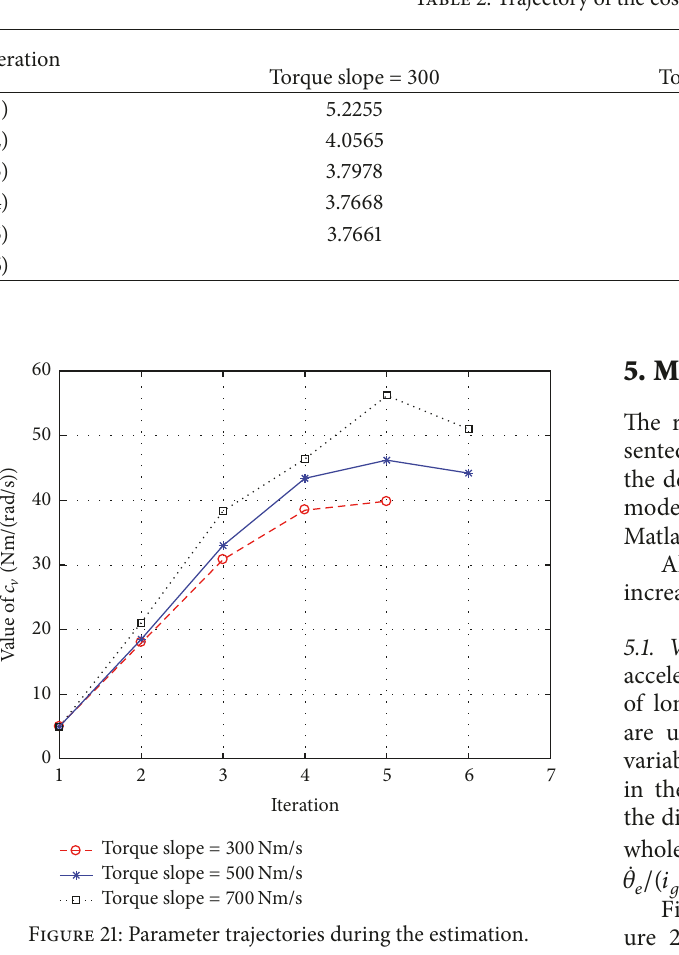
Table 2: Trajectory of the cost function 𝐽 .